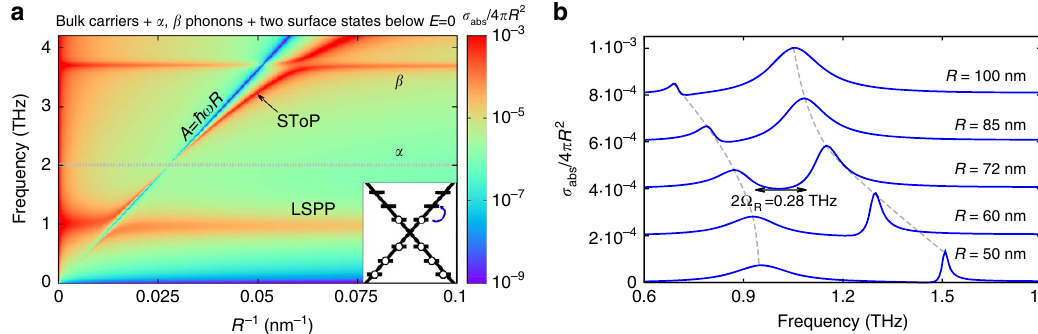
Figure 4 | Effects of varying Fermi energy. ( a ) Absorption cross-section of the TINP with two states immediately above the Dirac point occupied. The two uppermost electrons (at energy A / R ) are perturbed by incident light, which causes them to couple to empty states higher in energy (at 2 A / R ), leading to a line of suppressed absorption along A ¼ : wR and a SToP mode (marked with an arrow). ( b ) For this Fermi energy, there is a significant Rabi splitting due to the interaction of the SToP mode and the localised surface plasmon (LSPP). When the two modes avoid each other most ( R ¼ 72nm), the splitting O R ¼ 0.14THz is a considerable fraction of the average peak frequency ( 4 0.1), which is a signature of